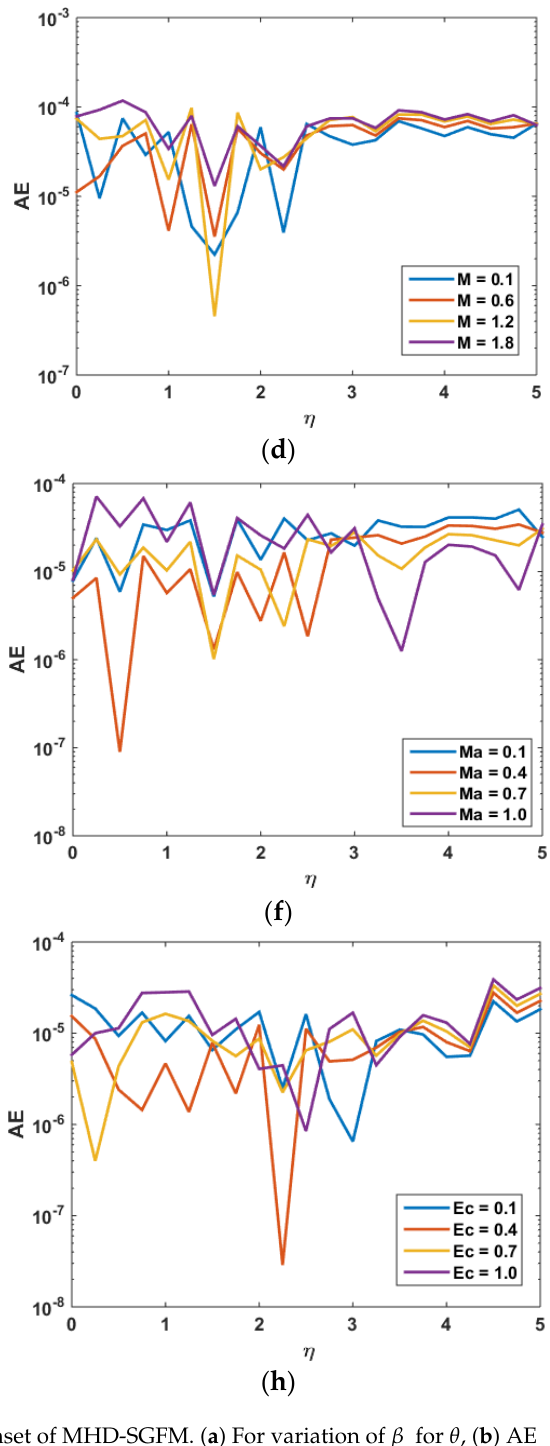
Figure 14. Assessment of LMT-ABPNN for 𝜃(𝜂) with reference dataset of MHD-SGFM. ( a ) For variation of 𝛽 for 𝜃 , ( b ) AE for MHD-SGFM , ( c ) For variation of 𝑀 for 𝜃 , ( d ) AE for MHD-SGFM, ( e ) For variation of 𝑀𝑎 for 𝜃 , ( f ) AE for MHD-SGFM, ( g ) For variation of Ec for 𝜃 , ( h ) AE for MHD-SGFM.